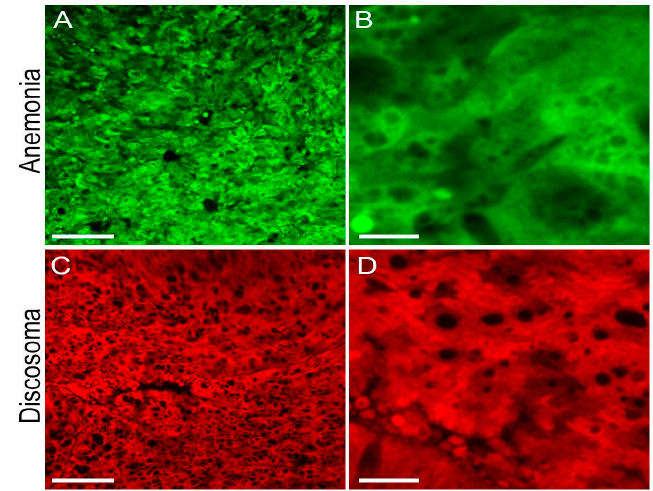
Figure 2. Confocal microscopy of live coral tissues. ( A , B ) Tip of the tentacle of Anemonia majano , excitation 488 nm, detection 500–540 nm (green FP); ( C , D ) Surface of Discosoma sp ., excitation 543 nm, detection 560–620 nm (red FP). Scale bars: ( A , C ), − 50 µm; ( B ), − 5 µm; ( D ), − 10 µm.